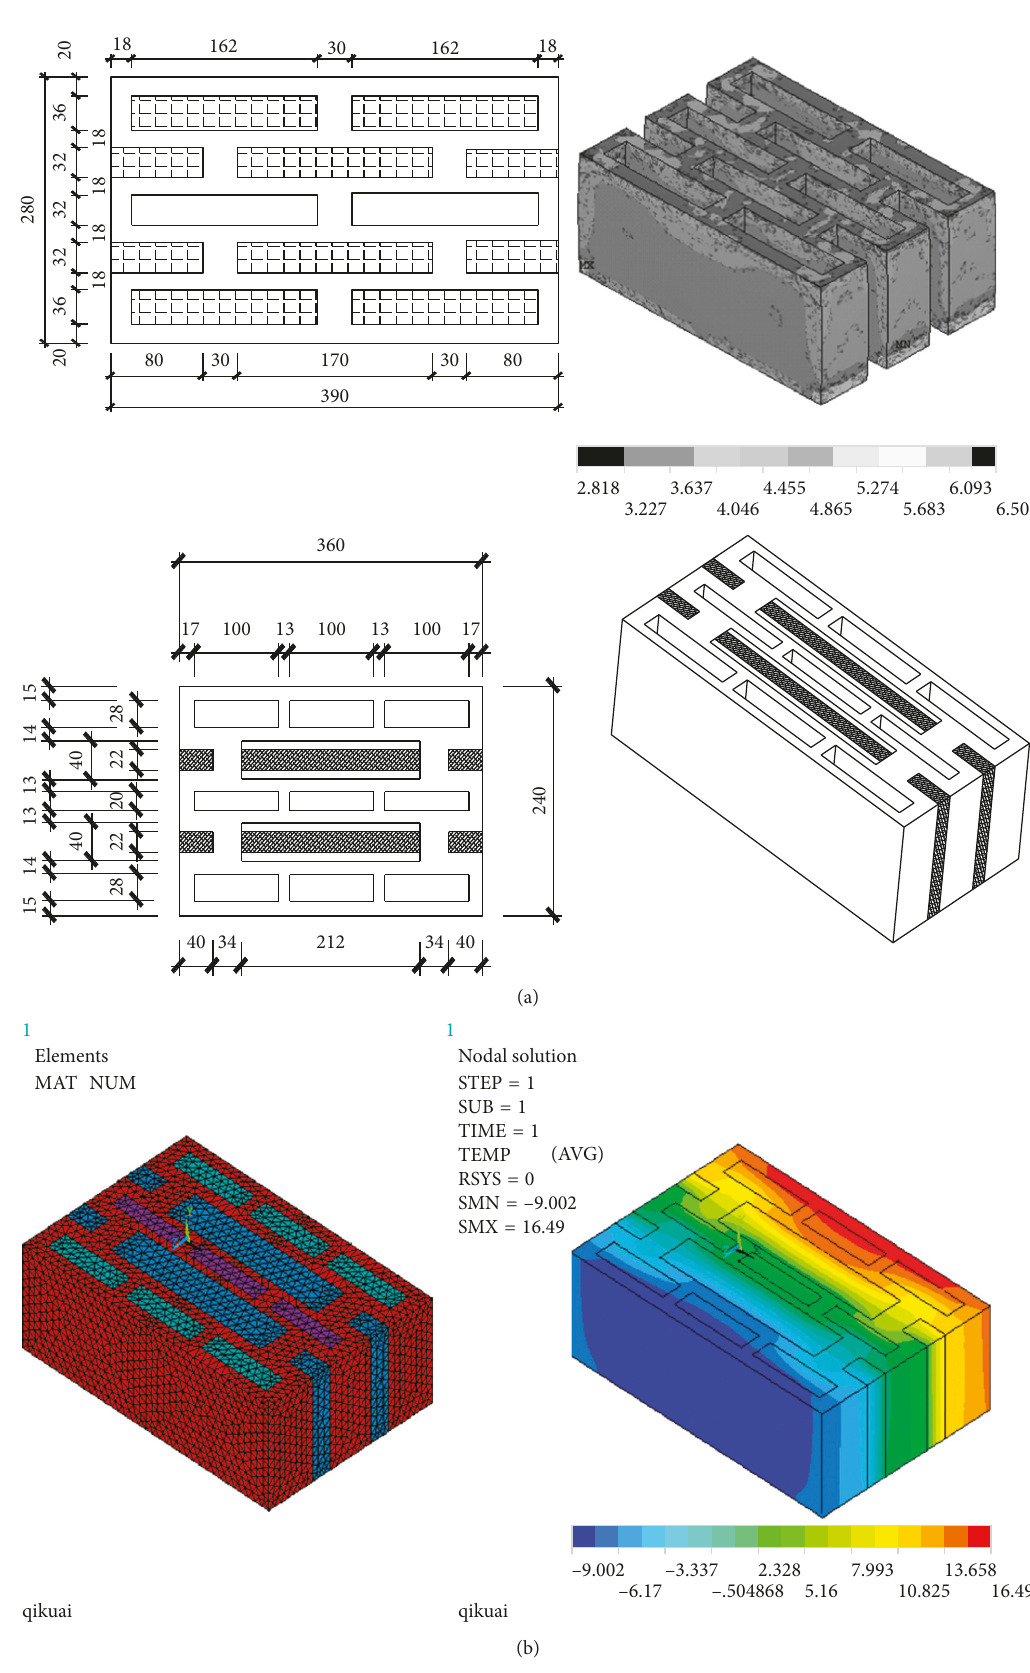
Figure 1: Self-insulating concrete masonry unit configurations: (a) samples of tested ECSB blocks and (b) thermal properties of proposed ECSB using